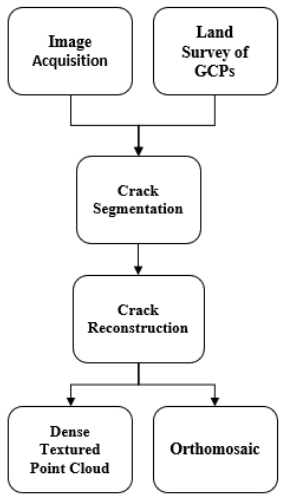
Figure 1. The framework of our proposed algorithm.